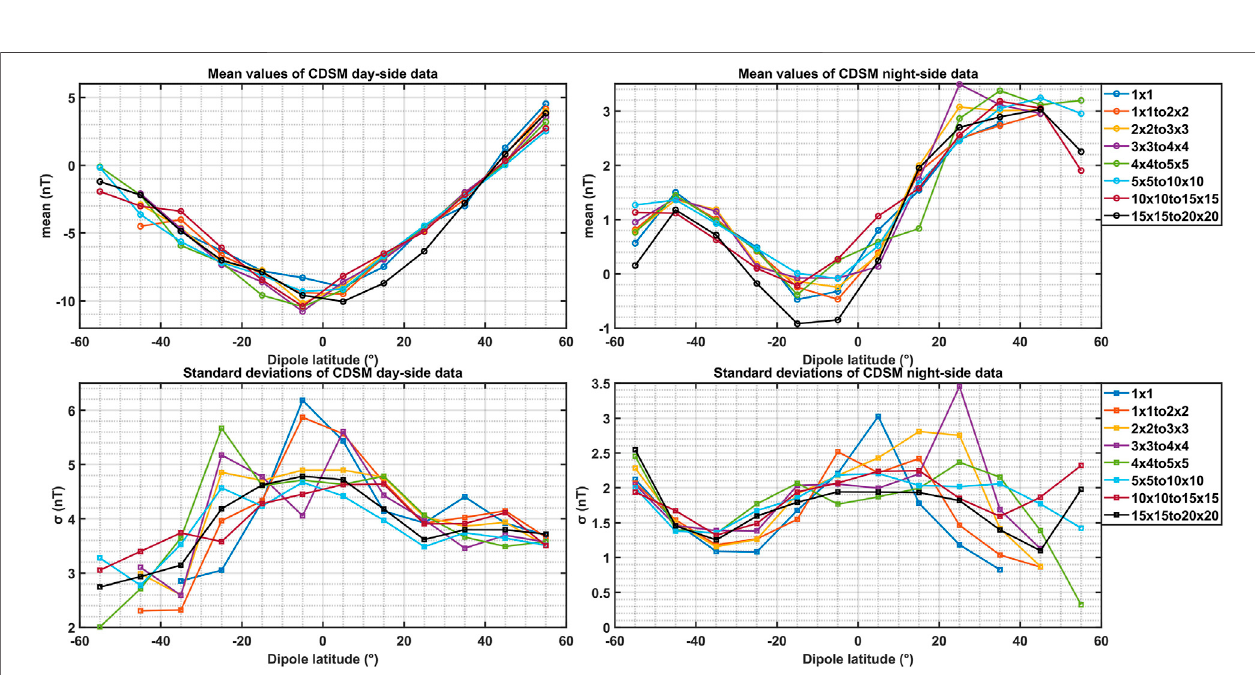
FIGURE 9 | Statistical results of mean values and standard deviations of Δ F from 31 July 2019 to 30 August 2019 with a time interval of 30 min and at increasing, non-overlapping distance ranges from 1 ° ×1 ° to 20 ° ×20 ° .